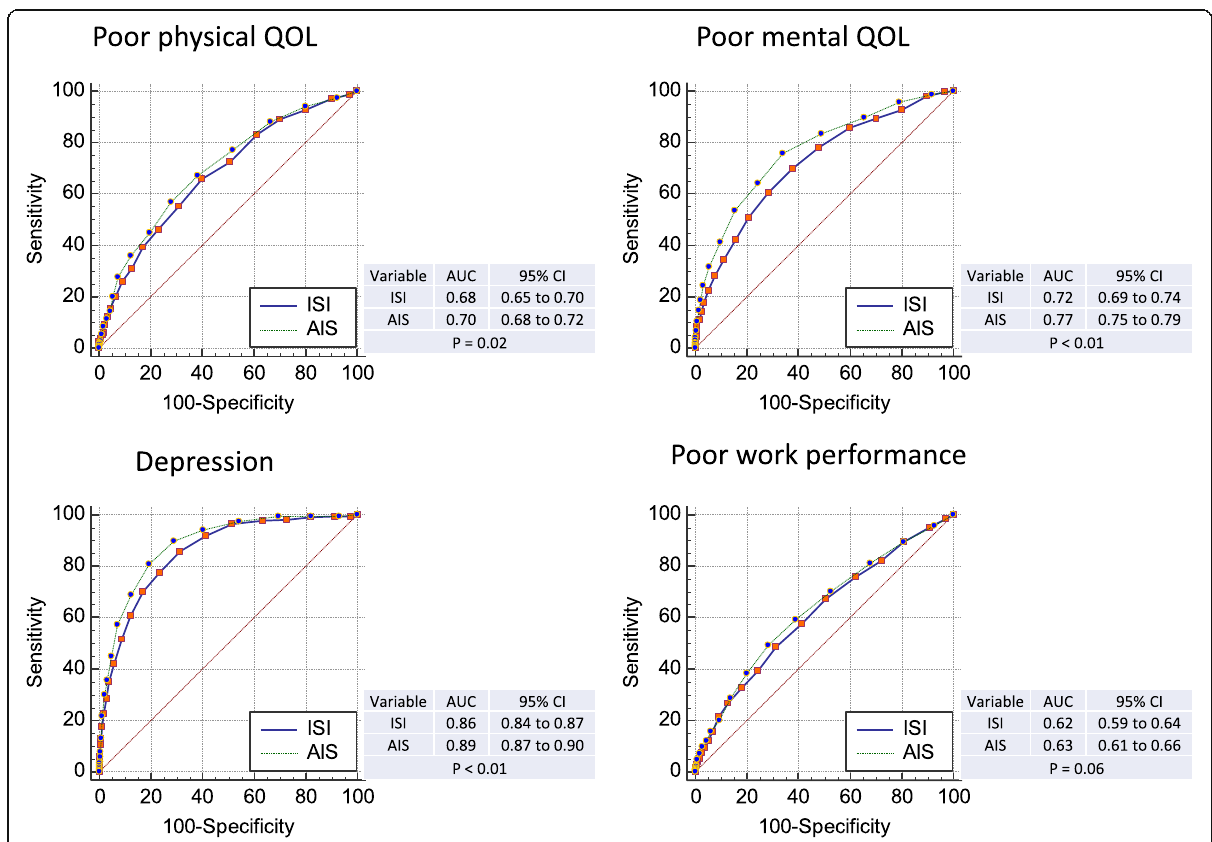
Fig. 2 Receiver operating characteristic (ROC) analysis of the Athens Insomnia Scale (AIS) and Insomnia Severity Index (ISI) scores and poor QOL, depression, and poor work performance. Health-related quality of life (QOL) as assessed by the Short Form-8 Health Survey Questionnaire (SF-8) was summarized into the physical continuous summary (PCS) and mental continuous summary (MCS) scores. Work performance was assessed by the absolute presenteeism score using the World Health Organization Health and Work Performance Questionnaire (WHO-WPQ). The lowest tertile of the PCS, MCS, and absolute presenteeism scores were classified as poor physical QOL, poor mental QOL, and poor work productivity, respectively. A Patient Health Questionnaire-9 (PHQ-9) score ≥ 10 was classified as depression. The p values represent the pairwise comparisons for the ROC curves of the ISI and AIS